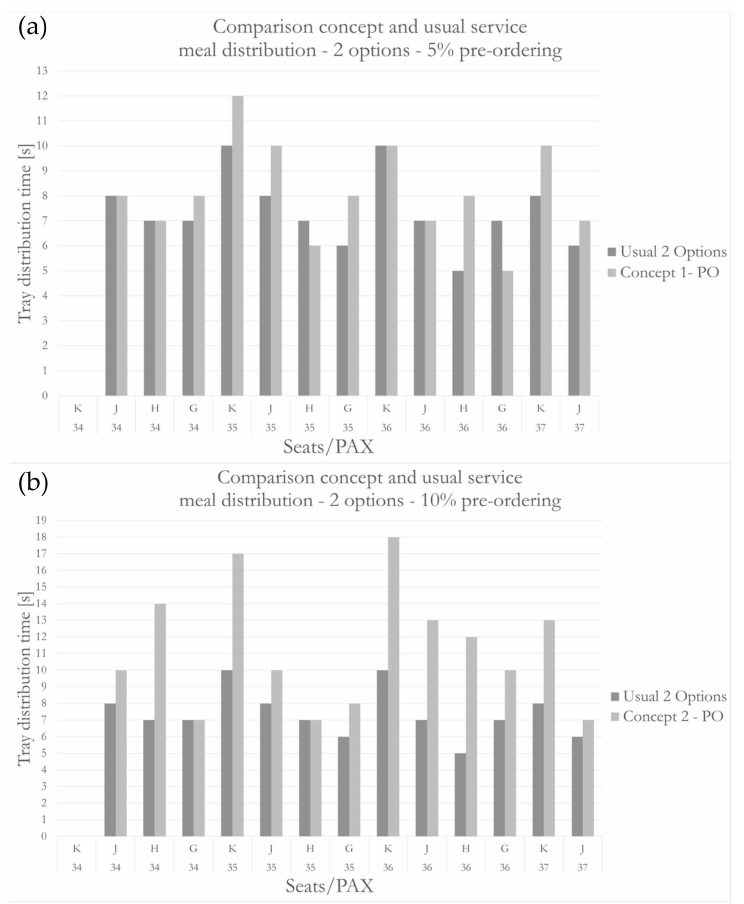
Figure 24. Meal service distribution with ( a ) 5% and ( b ) 10%